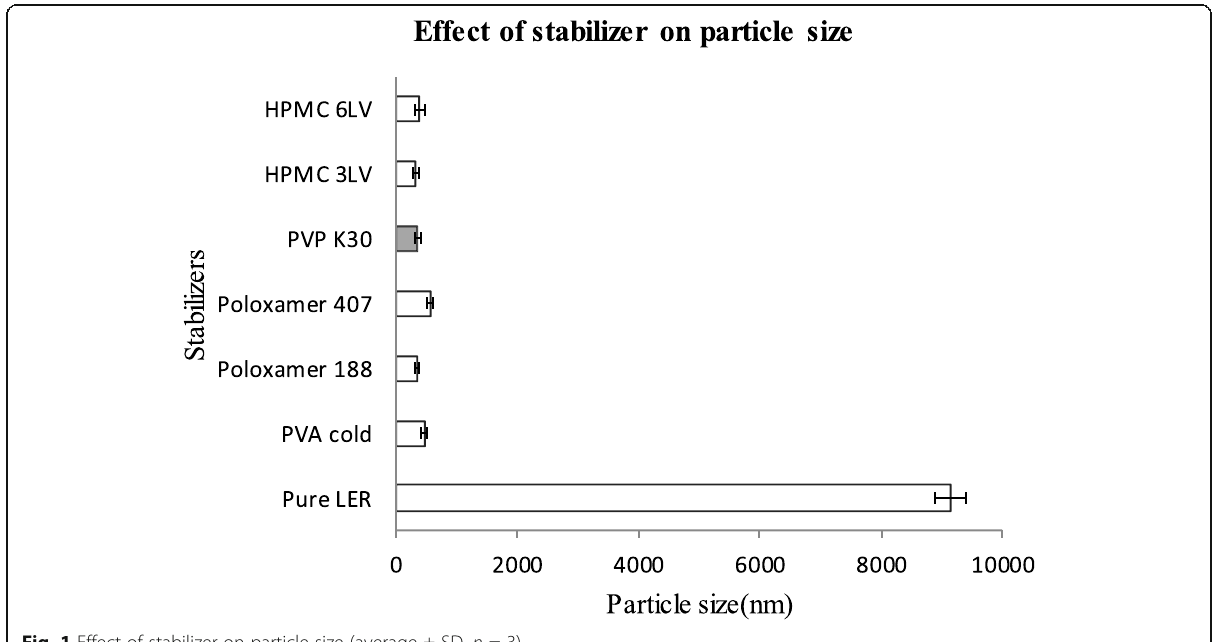
Fig. 1 Effect of stabilizer on particle size (average ± SD, n = 3)